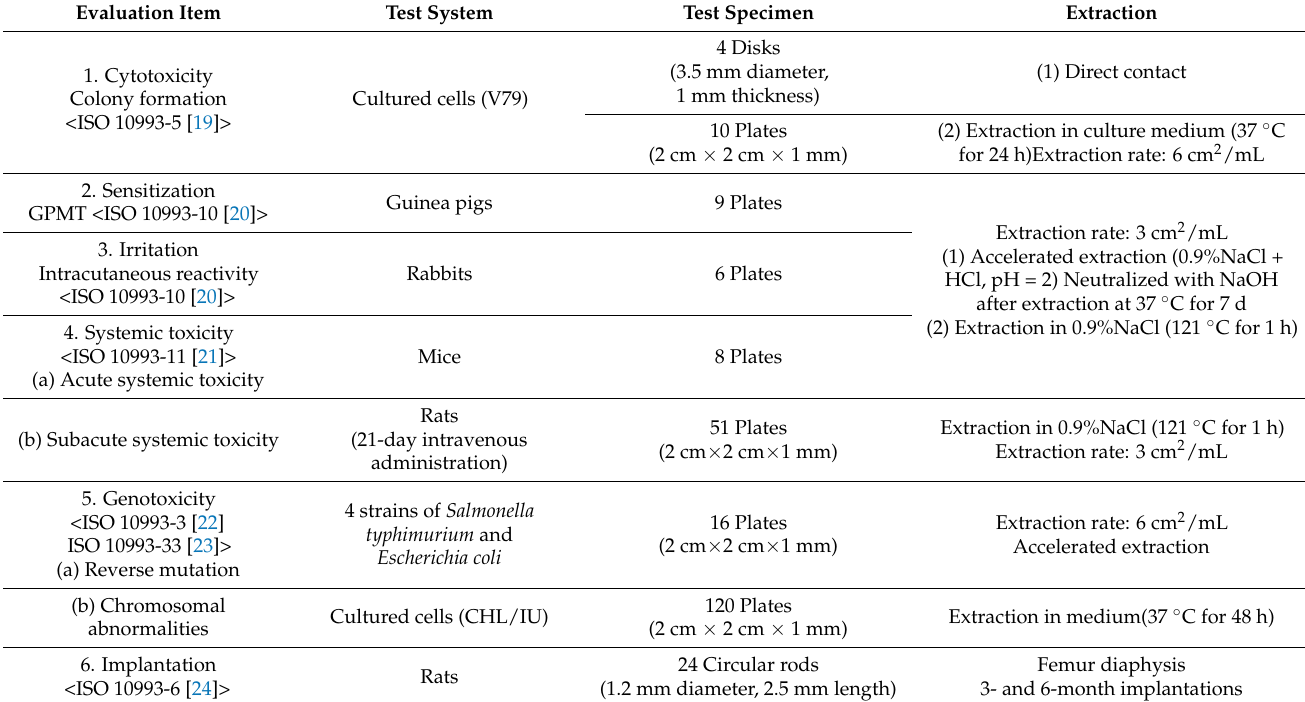
Table 2. Test conditions of biological safety evaluation used in this